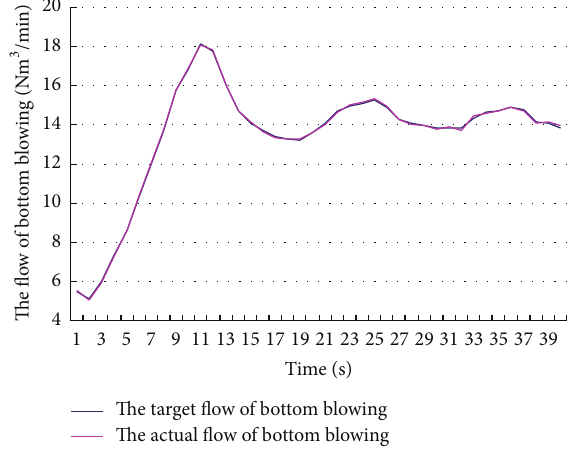
Figure 8: Dynamic curves between the actual flow and the target flow of bottom blowing.